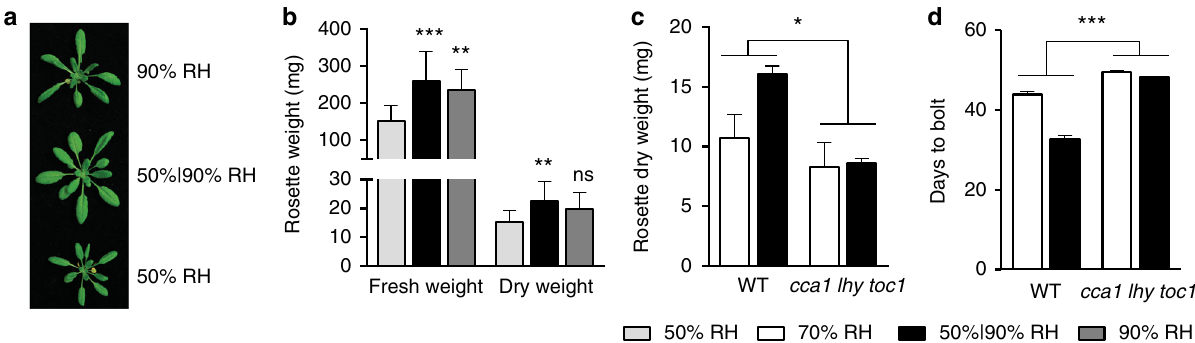
Fig. 1 Humidity oscillation in fl uences plant physiology in a core clock gene-dependent manner under constant light conditions. a , b Photograph ( a ) and weight ( b ) of leaf-rosette of 3-week-old plants grown under constant light (LL) with constant 50% relative humidity (RH), 90% RH, or 12 h 50%/12 h 90% oscillating RH. Data are shown as mean ± s.d. of n ≥ 11 plants; one-way ANOVA followed by Bonferroni ’ s multiple comparisons correction, ** p < 0.01, *** p < 0.001; ns not signi fi cant. This experiment was repeated two times with similar results. c Dry weight of leaf-rosette of 3-week-old WT and the core clock gene mutant cca1 lhy toc1 plants grown under LL with constant 70% RH or 12 h 50%/12 h 90% RH. Data are shown as mean ± s.d. of three experimental replicates representing at least 45 plants from a single parent line. Data were combined using linear mixed effect model (lme4) with experiment as random effects; two-way ANOVA, * p < 0.05. d Flowering time of plants grown under LL with constant 70% RH or 12 h 50%/12h 90% RH. Data are shown as mean ± s.d. of three experimental replicates representing at least 78 plants from a single parent line. Data were combined using linear mixed effect model (lme4) with experiment as random effects; two-way ANOVA, *** p <